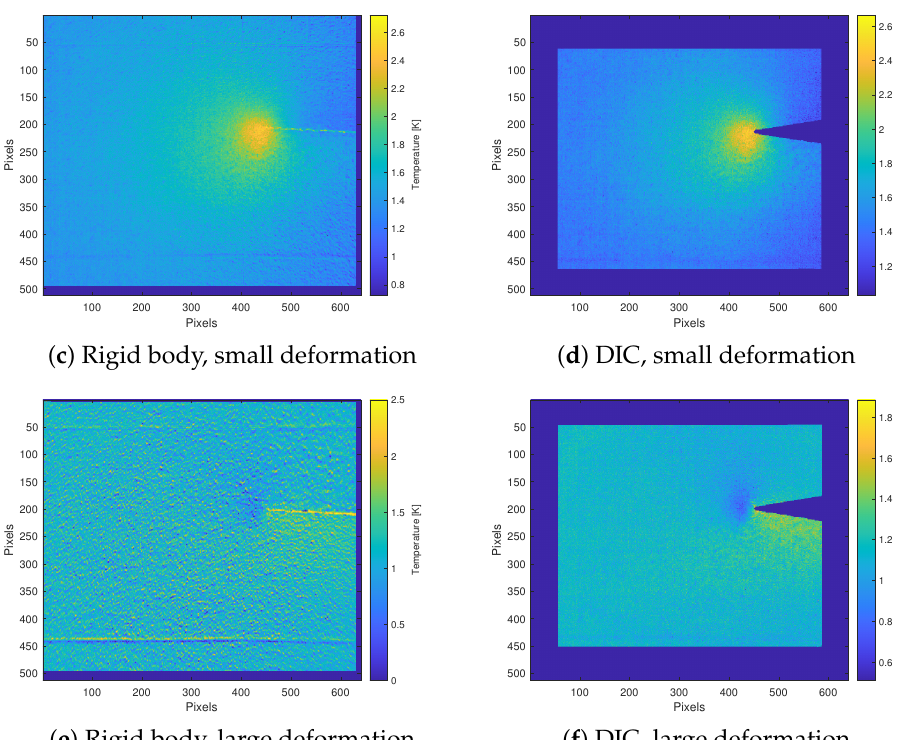
Figure 12. Comparison of the raw image obtained during cyclic FCG testing ( a ), and the results of background subtraction of the reference image ( b ) using rigid body ( c , e ), and IRT/DIC-based image subtraction ( d , f